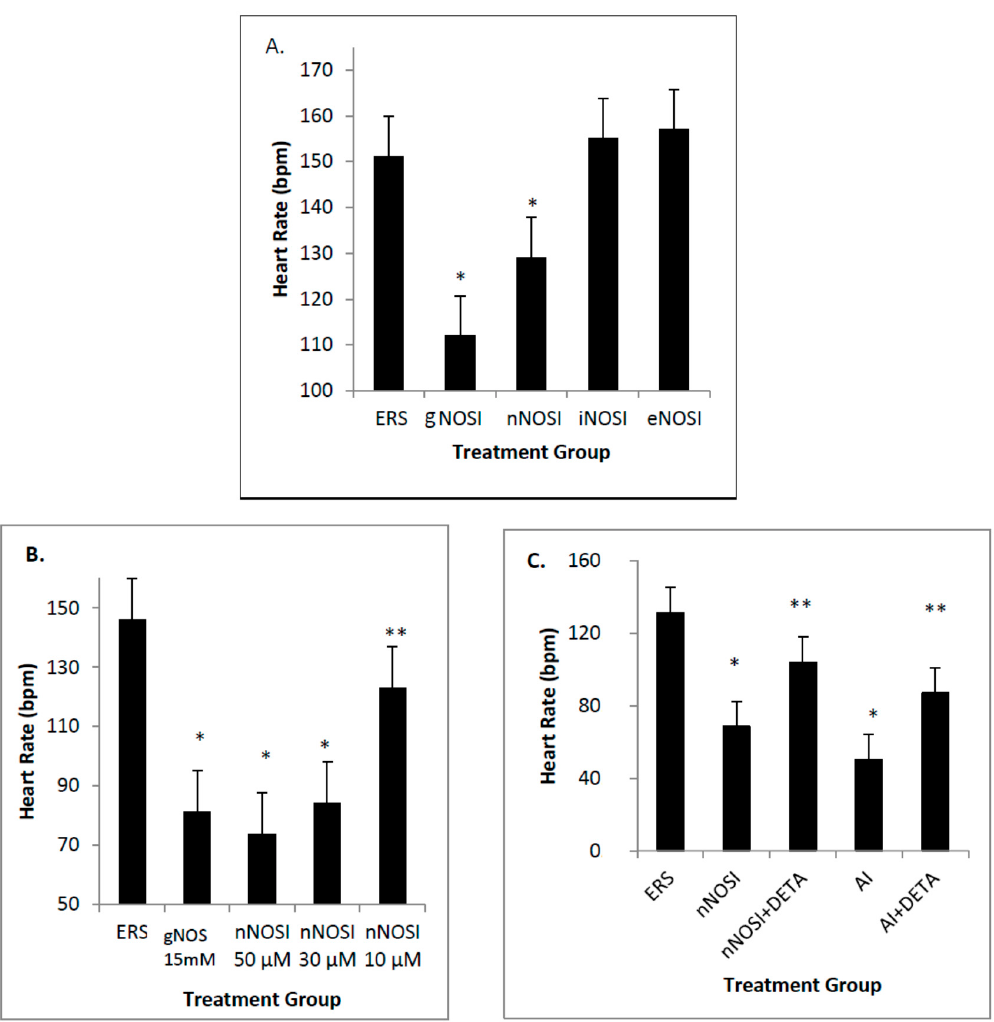
Figure 2. The effects of various treatments on fish heart rates (HR) in beats/minute (bpm) after 4 days of treatment beginning at 48 h post fertilization (hpf). ( A ) The only significant decrease in HR among the three NOS isoform inhibitors was induced by the nNOSI treatment ( p < 0.001). The nNOSI (50 µ M) treatment is shown to closely mimic the significant decrease in HR initiated by the gNOSI (15 mM) treatment; ( B ) This figure shows a dose–response analysis for varying concentrations of nNOSI on fish HRs. ERS (control embryo rearing solution) was used as a control to measure the effectiveness of the different nNOSI concentrations. Specifically, data shows that nNOSI at 30 and 50 µ M lowered HR in a dose dependent manner when compared to the 10 µ M concentration ( p < 0.05 for both). Note that gNOSI also significantly reduced HR in a manner similar to that of nNOSI; ( C ) This figure shows the HR rescue effect initiated by combining both nNOSI or AI (50 µ M) with DETA-NO (50 µ M) as an NO donor ( p < 0.002 for nNOSI + DETA-NO vs. nNOSI and p < 0.001 for AI (50 µ M) + DETA vs. AI). Double labeled asterisk group indicate a significant difference from their single asterisk counterparts. All bars = ± SD.